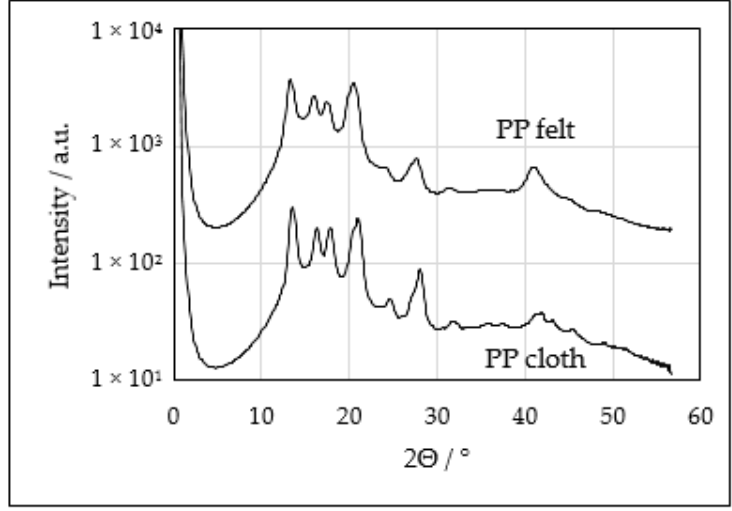
Figure 7. WAXS spectrum of PP-felt and PP-cloth typical for tailings filtration.